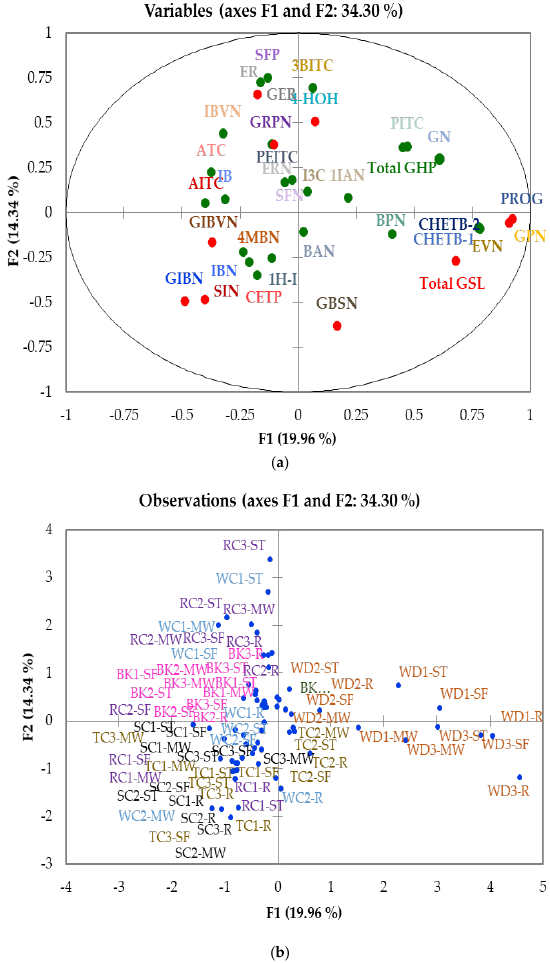
Figure 5. MFA map of glucosinolates and glucosinolate hydrolysis products ( a ) distribution of variables and ( b ) sample distribution. Abbreviations: R = raw, ST = steamed; MW = microwaved; SF = stir-fried; BK1: cavolo nero di toscana o senza palla (BK-CNDTP); BK2: cavolo palmizio (BK-CPNT); BK3: cavolo nero di toscana o senza testa (BK-CNDTT); WD1: wild cabbage 8707 (WD-8707); WD2: wild cabbage 7338 (WD-GRU); WD3: wild cabbage 8714 (WD-8714); TC1: penca mistura (TC-PCM); TC2: penca povoa (TC-CPDP); TC3 tronchuda (TC-T); SC1: hybrid savoy wirosa (SC- HSC); SC2: pointed winter (SC-PW); SC3: dark green (SC-SDG); RC1: red langendijker (RC-RL); RC2: rocco marner (Hybrid) (RC-RM); RC3: red Danish (RC-RD); WC1: early market (WC-FEM); WC2: couve repolho (WC-CRB). Colour codes: Pink = Black kale; Brown = Wild cabbage; Dijon yellow = Tronchuda cabbage; Black = Savoy cabbage; Purple = Red cabbage; Blue = White cabbage. Compounds with different shades of the same colour in Figure 5a refer to the GSL and corresponding GHPs. For compound codes on plot, refer to Tables 1 and